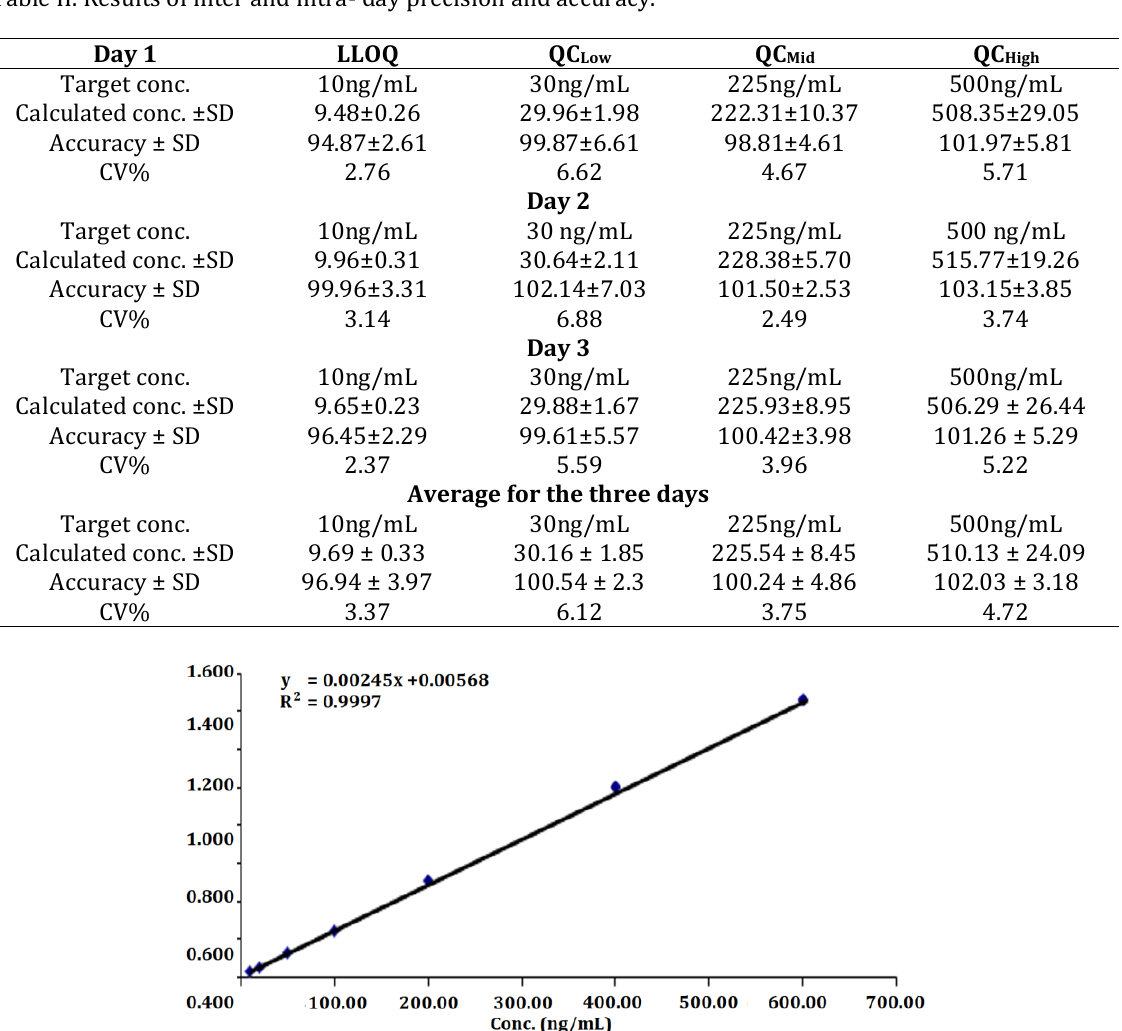
Figure 3. The plot of linearity of calibration curve levels for montelukast quantification against their analytical response and regression linear